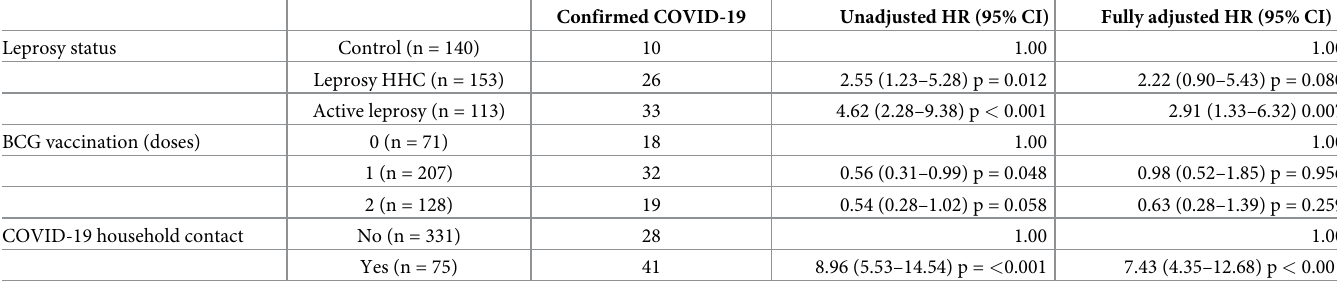
Table 2. Exploratory analysis testing the effects of leprosy status, BCG and COVID household contact on the risk of COVID-19 (N =